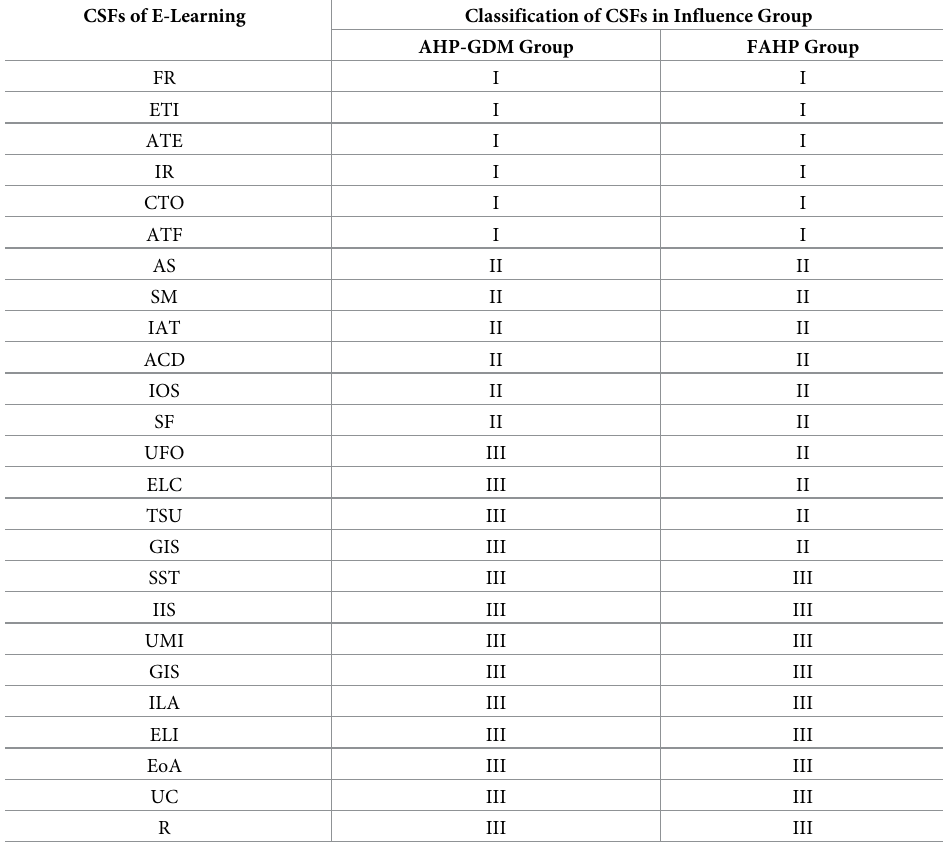
Table 14. Classification of CSFs of E-Learning into varying degree of